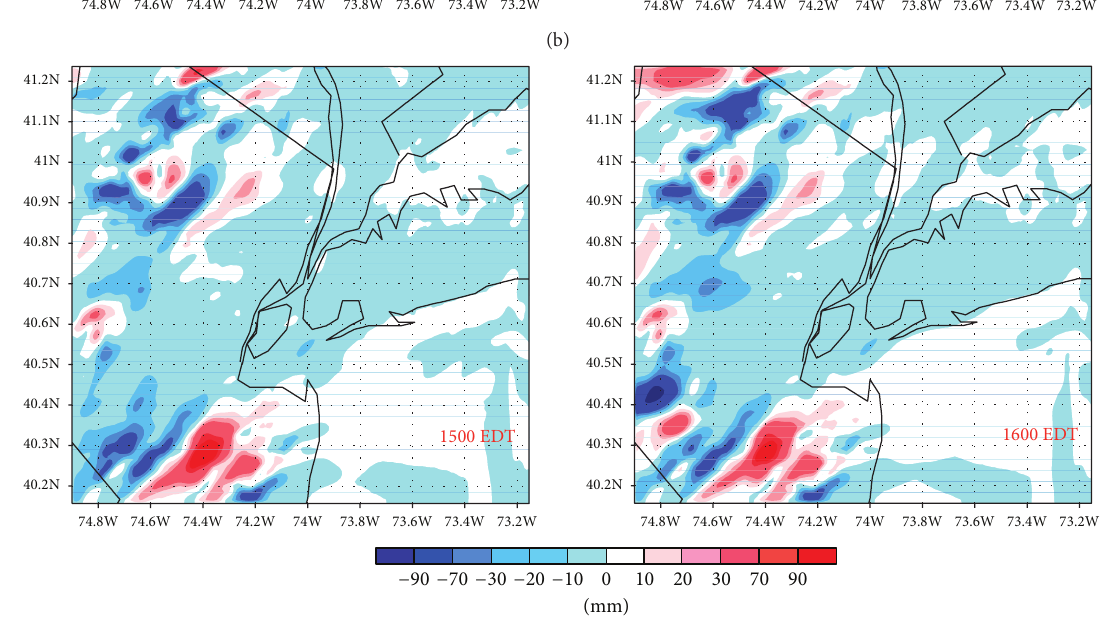
Figure 10: Hourly total accumulated precipitation difference between Run 1 and Run 2 over